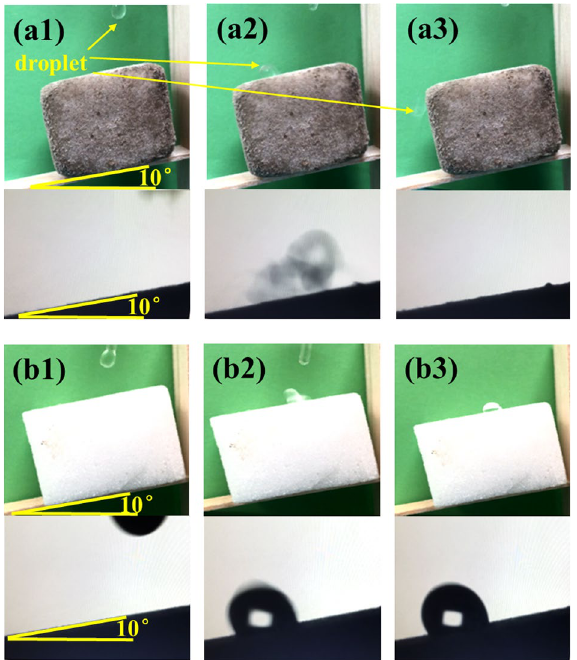
Figure 8. ( a1 – a3 ) The sliding angle test of OTS-PDA-MS. ( b1 – b3 ) The sliding angle test of OTS-MS.